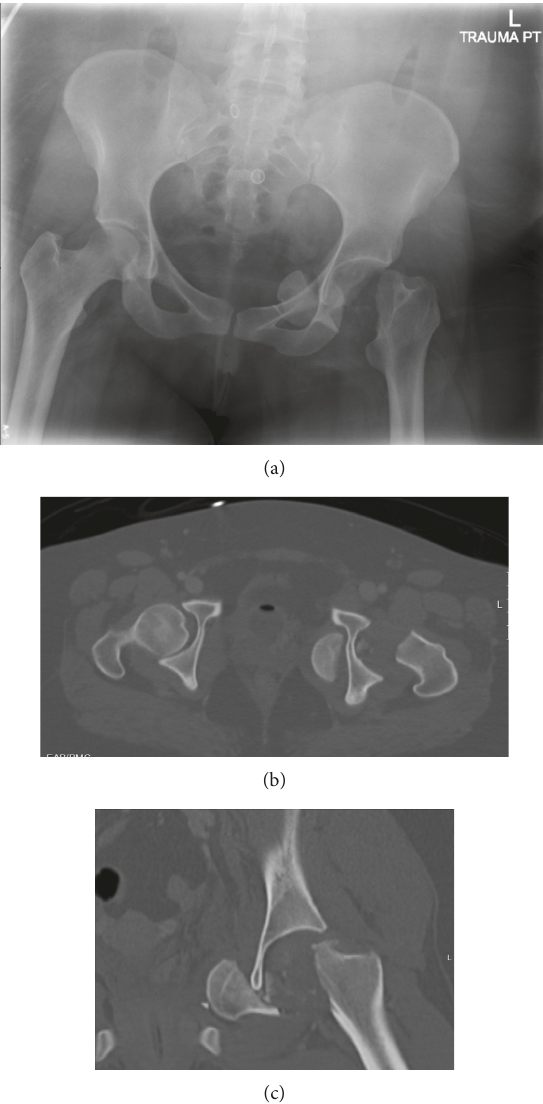
Figure 1: (a) Anteroposterior radiograph demonstrating complete medially displaced left femoral neck fracture. (b, c) Computed tomography (CT) demonstrating the displacement of femoral head in the intrapelvic location, which had extruded through the ob- turator